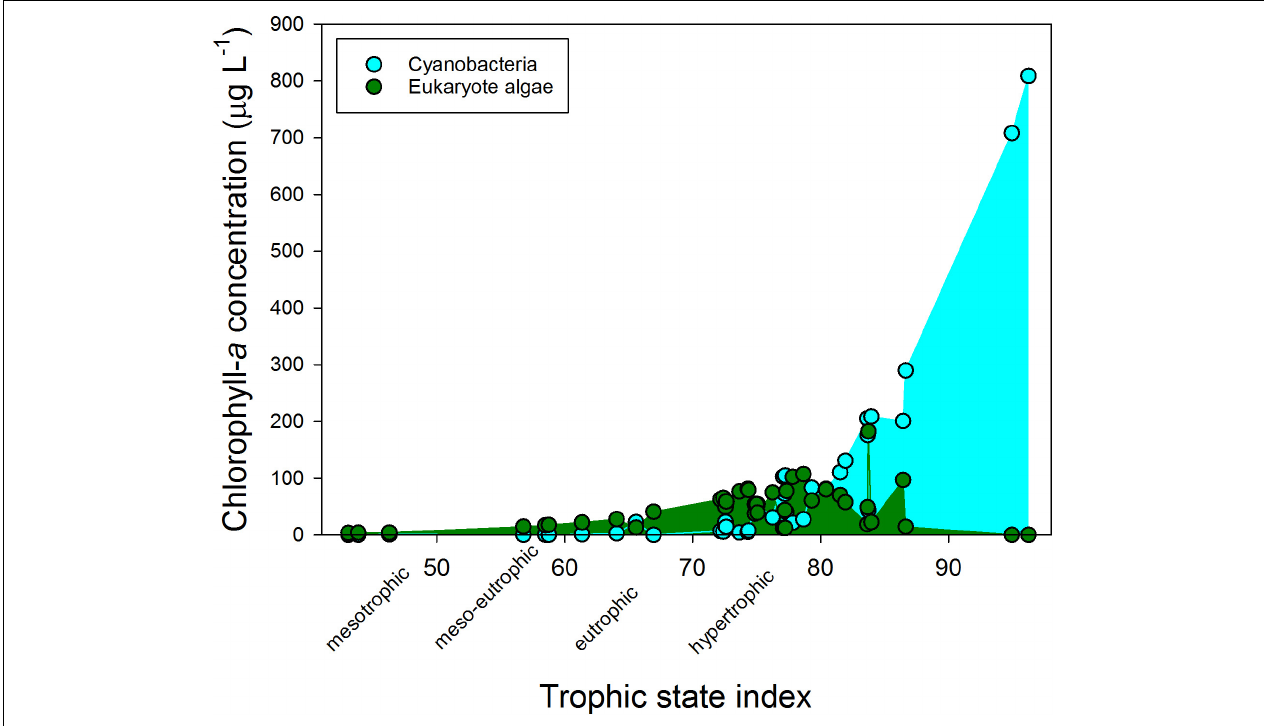
FIGURE 1 | Cyanobacterial (blue) and eukaryote phytoplankton (green) chlorophyll-a concentrations ( µ g l − 1 ) in fresh waters sampled in the Netherlands in summer 2010 and that were used in the experiments. The trophic state index is calculated from the total chlorophyll-a concentrations according to Carlson (1977).